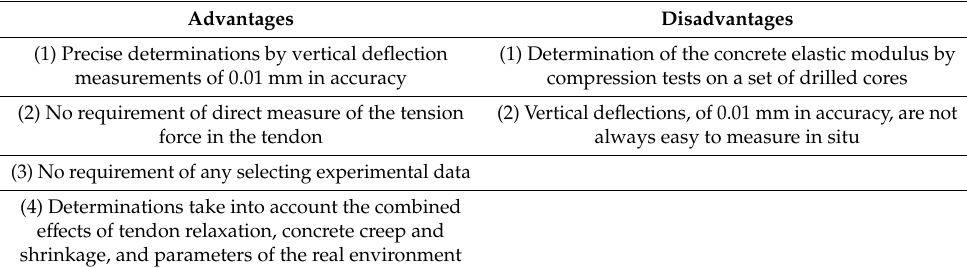
Table 5. Characteristics of the static NDT method preliminary proposed by Bonopera et al. [80] for determining prestress losses in PC